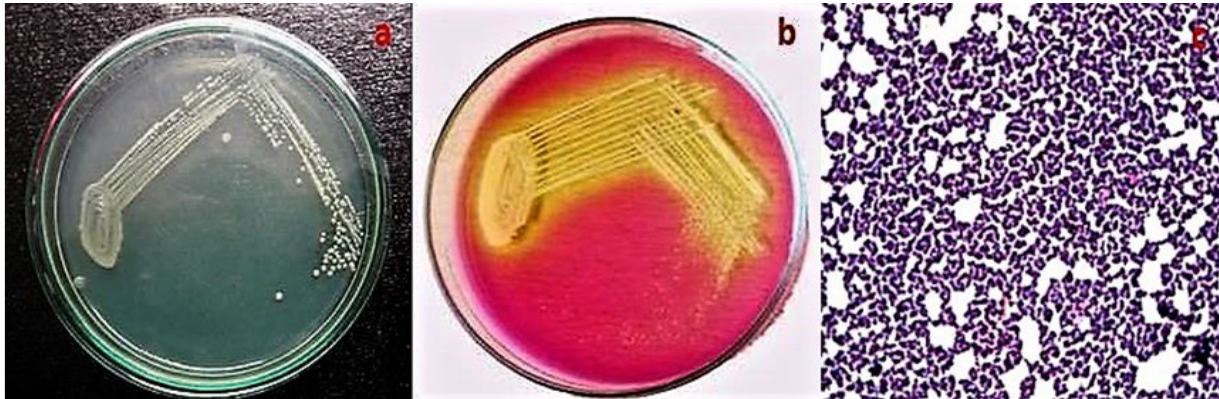
Figure 1. Morphological and microscopical view of CASMTK1 on ( a ). Nutrient agar, ( b ). Mannitol salt agar, ( c ). Gram’s staining clusters of the Staphylococcus sp., under light microscope. Cultural Characteristics: They are aerobes and facultative anaerobes. Optimum temperature for growth is 37 ◦ C range being 12–44 ◦ C. Optimum pH is 7.5. ( a ) Nutrient agar: After overnight incubation at 37 ◦ C colonies are 1–2 mm in diameter with a smooth glistering surface. They are opaque and easily emulsifiable. Most of the strains produce non diffusible golden yellow carotene pigment, though some strains are white colonies, ( b ) Mannitol salt agar: 1% mannitol, 7.5% sodium chloride and 0.0025% phenol red are added to nutrient agar. This is both selective and indicator medium. Most strains of S. aureus ferment mannitol therefore, due to the production of acids their colonies are surrounded by yellow zones. Otherwise, the colonies resemble those seen on nutrient agar, ( c ) Gram’s staining: Staphylococci are Gram positive cocci about 0.5–1.0 µ m in diameter. They are arranged in irregular grape like clusters, pairs and occasionally in short